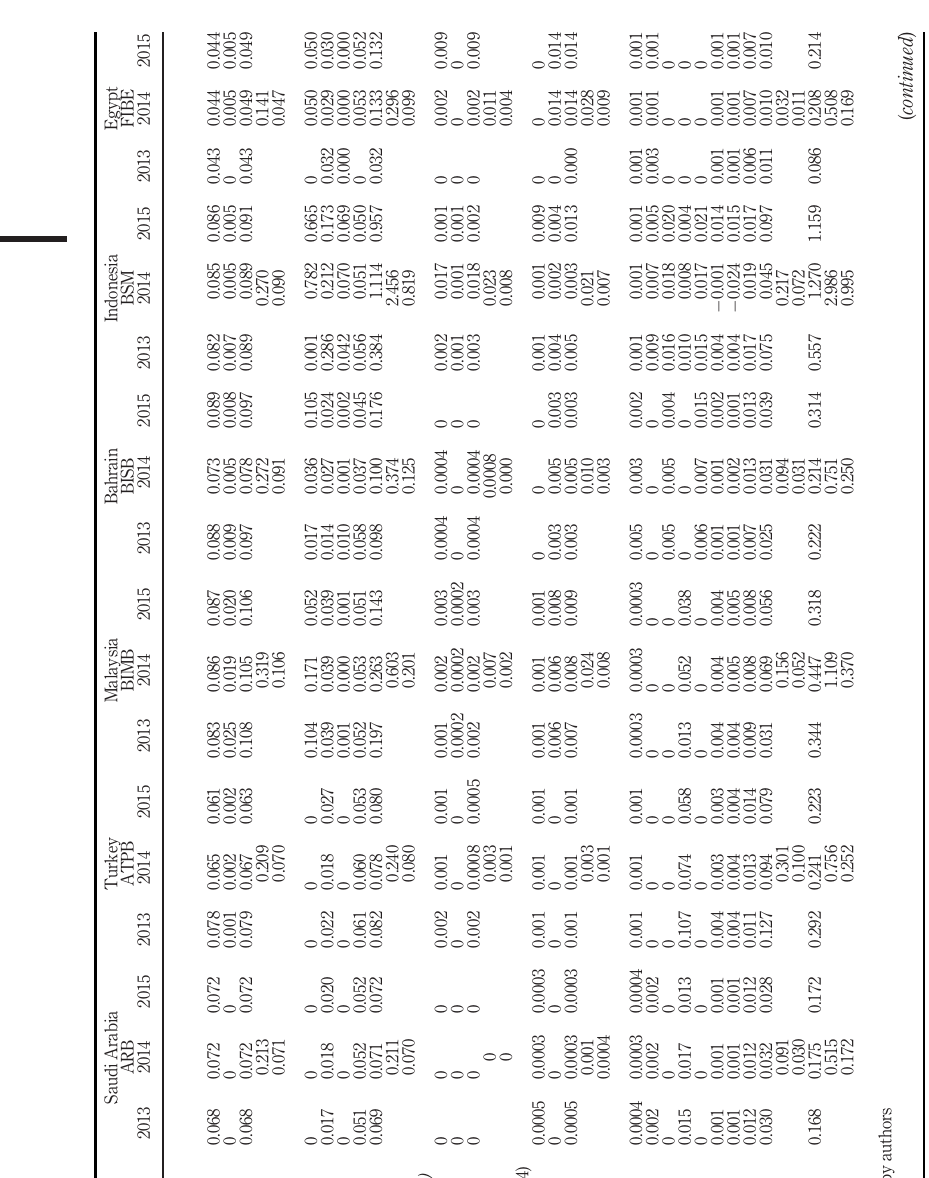
Table IV. Results of the sample ’ s performance analyzed using